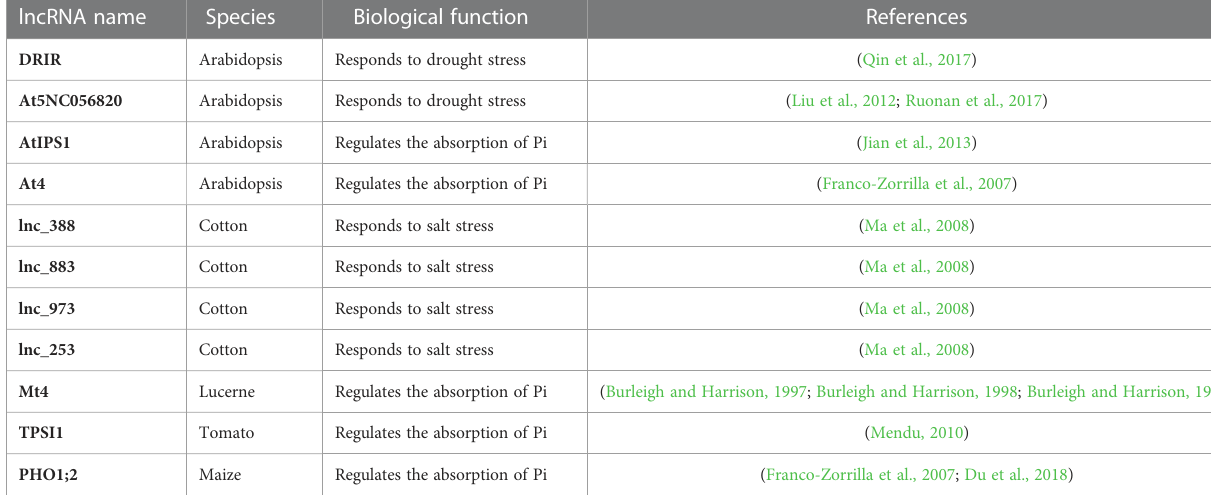
TABLE 3 lncRNAs involved in abiotic stress